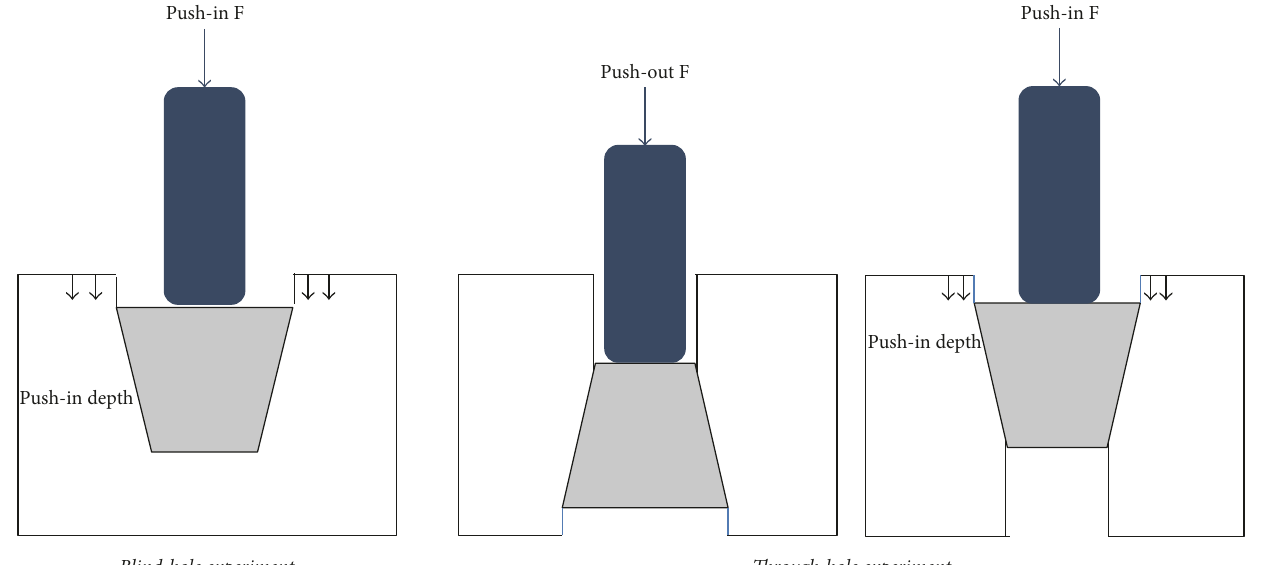
Figure 1: Schematics of blind and through holes